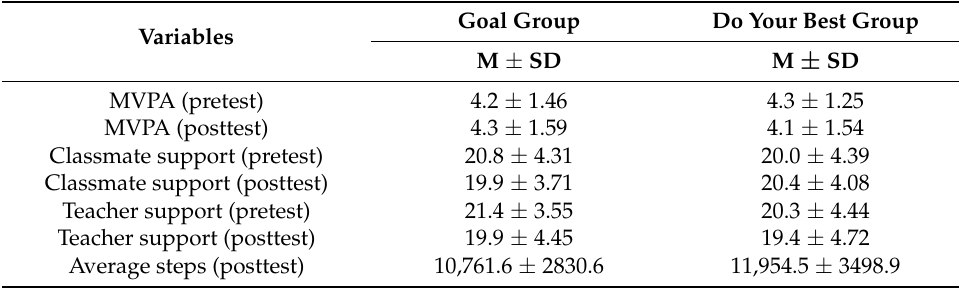
Table 1. Means and standard deviations in examined variables in pretest and posttest.